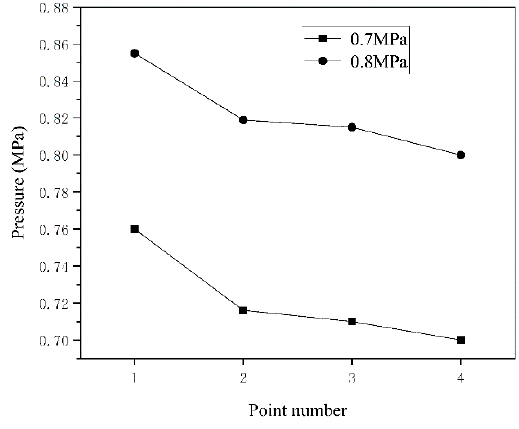
Figure 9. The pressure information of the key points on the discharge flow path.